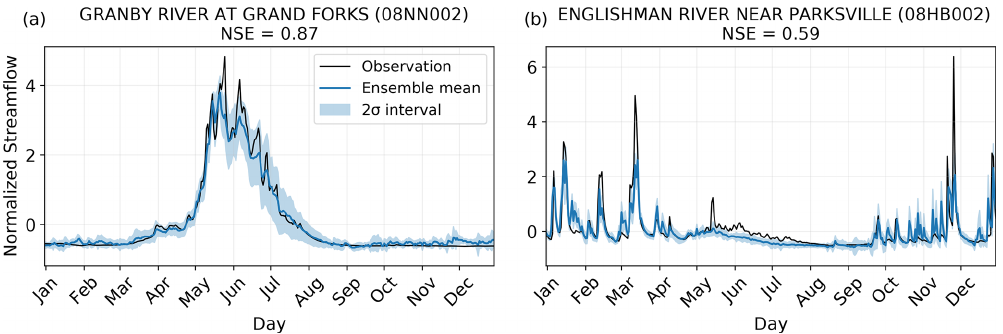
Figure 6. Examples of observed and modelled streamflow for 1 year at two stations of different streamflow regimes. The ensemble mean is the mean across the 10 model runs, and the shaded area is plus/minus 2 standard deviations across the 10 model runs. The station with the fifth-highest NSE is chosen in each of the southern and coastal clusters, which are snowmelt- and rain-dominated clusters, respectively. We chose the fifth best performing station to show more typical model performance for these clusters. An arbitrary year in the test set is chosen.